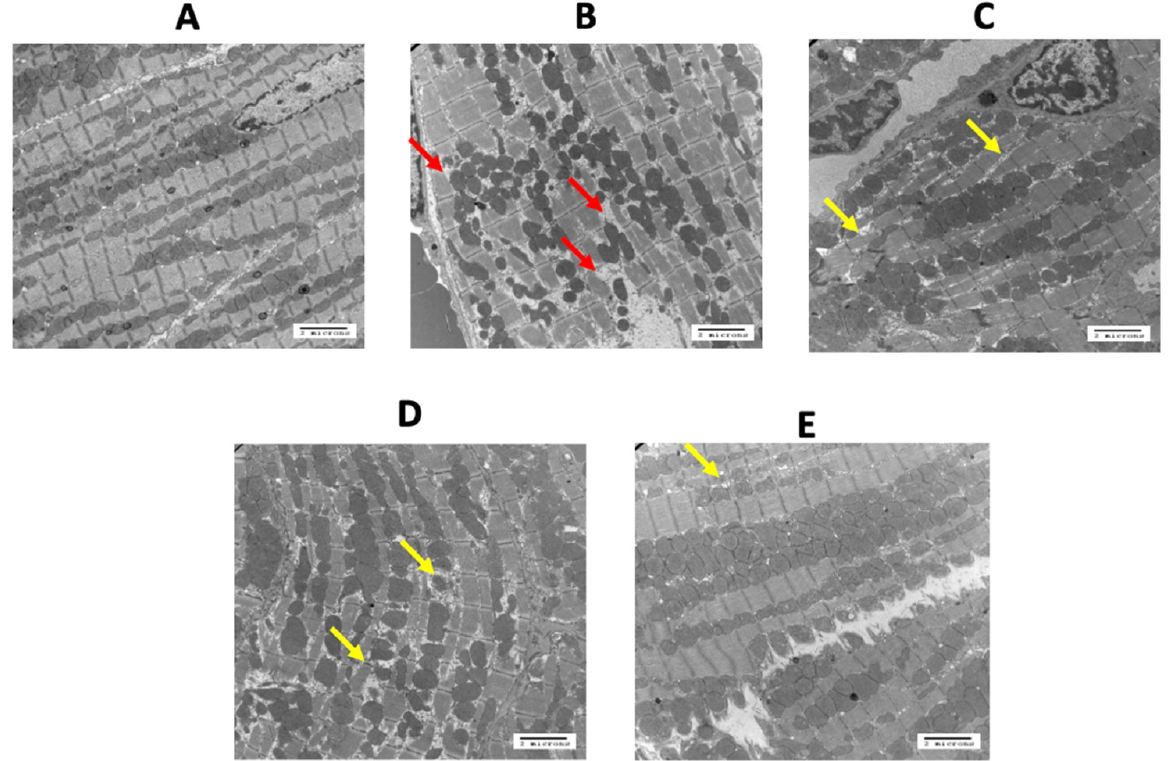
Figure 4. Ultrastructural changes in mice treated with DOX + TRZ prophylactically administered FLX, PER, or FLX + PER. Representative electron microscopy images of heart sample from C57Bl/6 female mice taken at 5800 × magnification. (Panel A ): RC + saline showcasing normal cellular integrity. (Panel B ): RC + DOX + TRZ treatment led to severe damage and myofibril integrity (red arrows). Prophylactic treatment with FLX (Panel C ), PER (Panel D ), and FLX + PER (Panel E ) partially prevented DOX + TRZ-mediated myocyte damage (yellow arrows). DOX, doxorubicin; FLX, flaxseed; PER, perindopril; RC, regular chow; TRZ, trastuzumab.